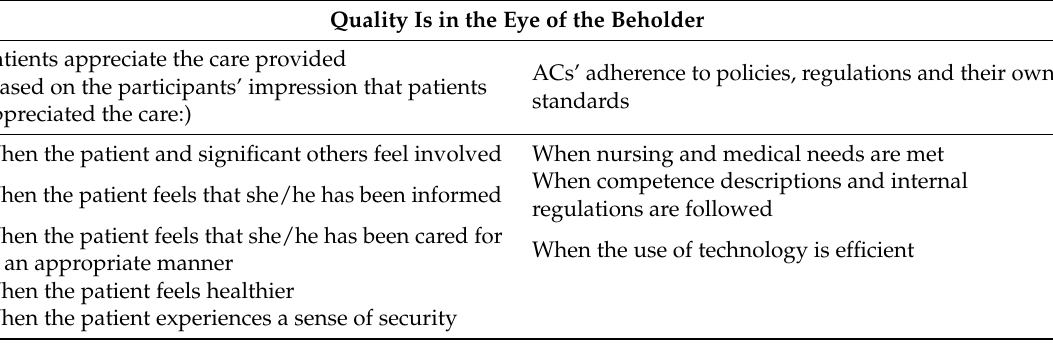
Table 2. Summary of the theme, categories and sub-categories that describe how ambulance clinicians, physicians, and managers experience what constitutes quality in the AS